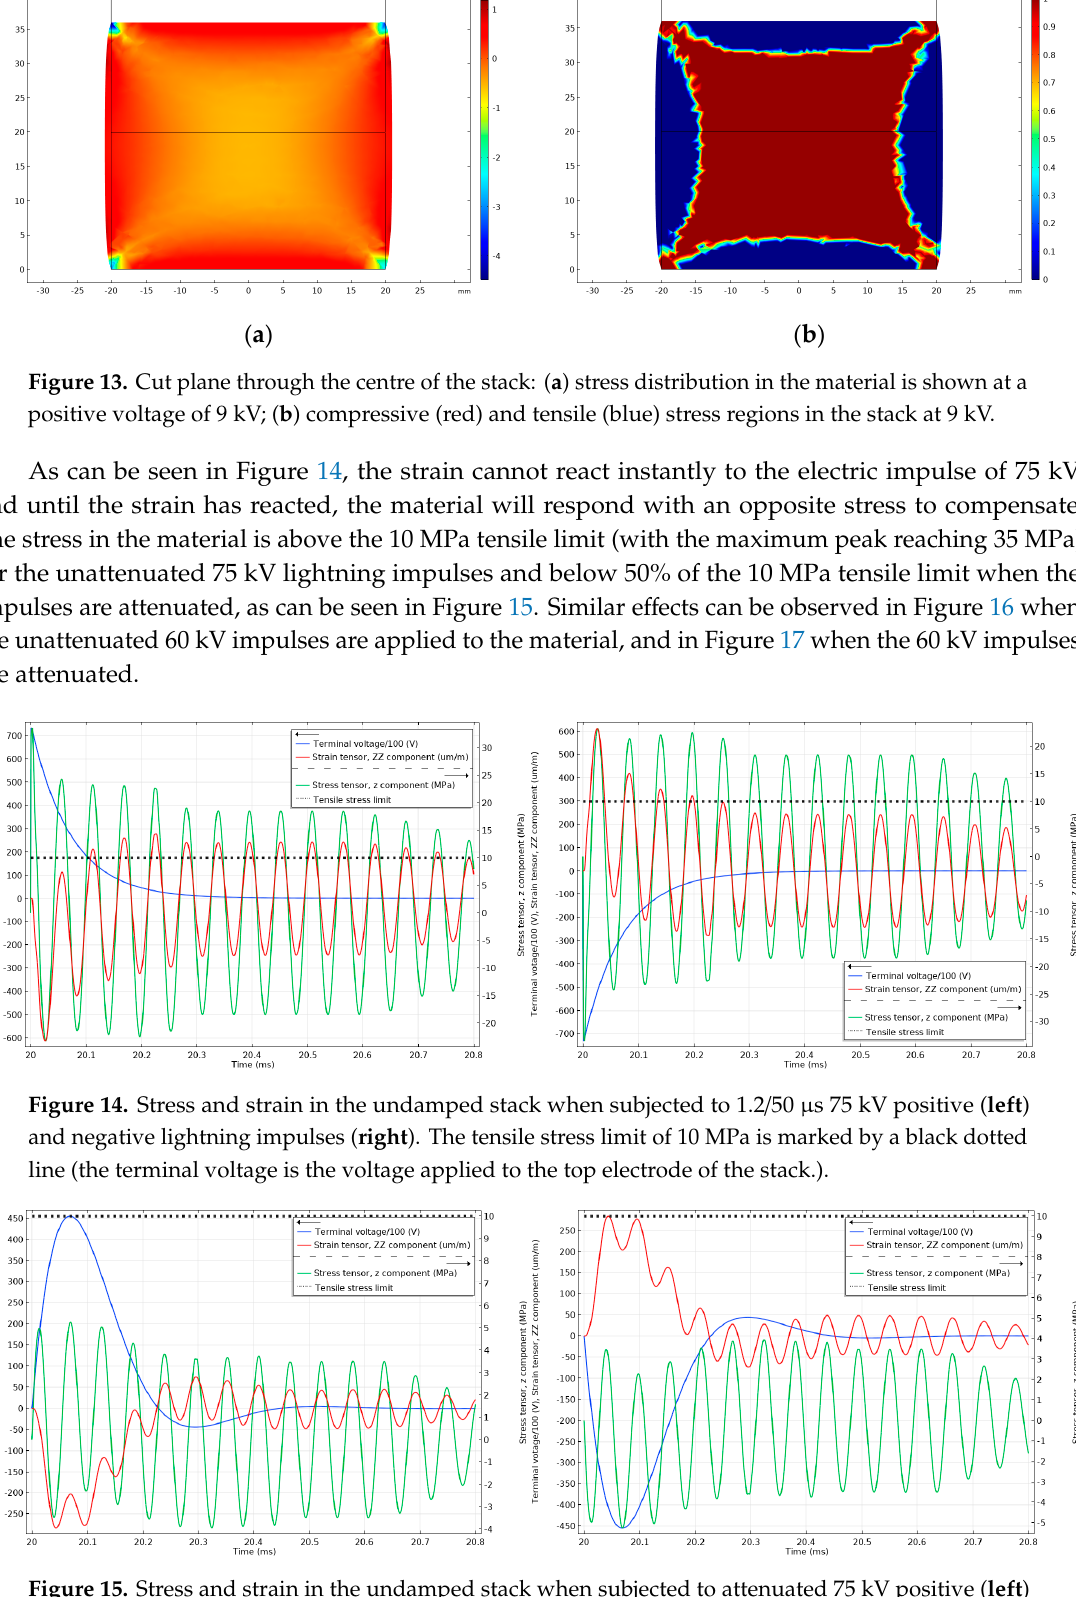
Figure 15. Stress and strain in the undamped stack when subjected to attenuated 75 kV positive ( left ) and negative ( right ) lightning impulses. The tensile stress limit of 10 MPa is marked by a black dotted line (the terminal voltage is the voltage applied to the top electrode of the stack.).